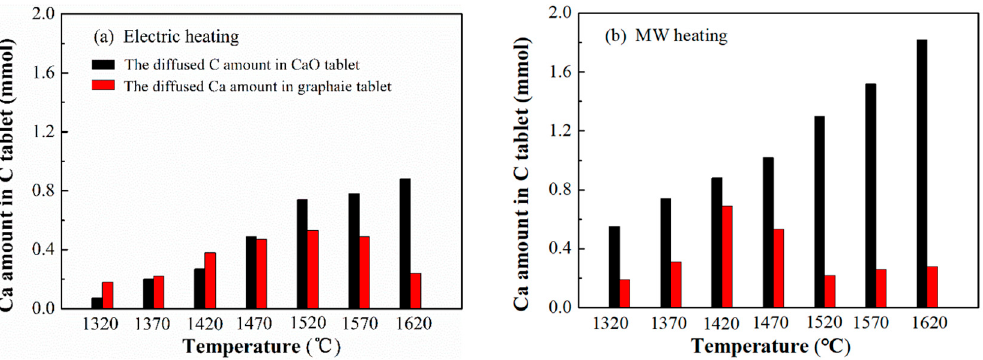
Figure 7. The diffused C amounts in CaO pellets and the diffused CaO amounts in graphite pellets heated by electric heating ( a ) and MW heating ( b ) under Ar atmosphere.